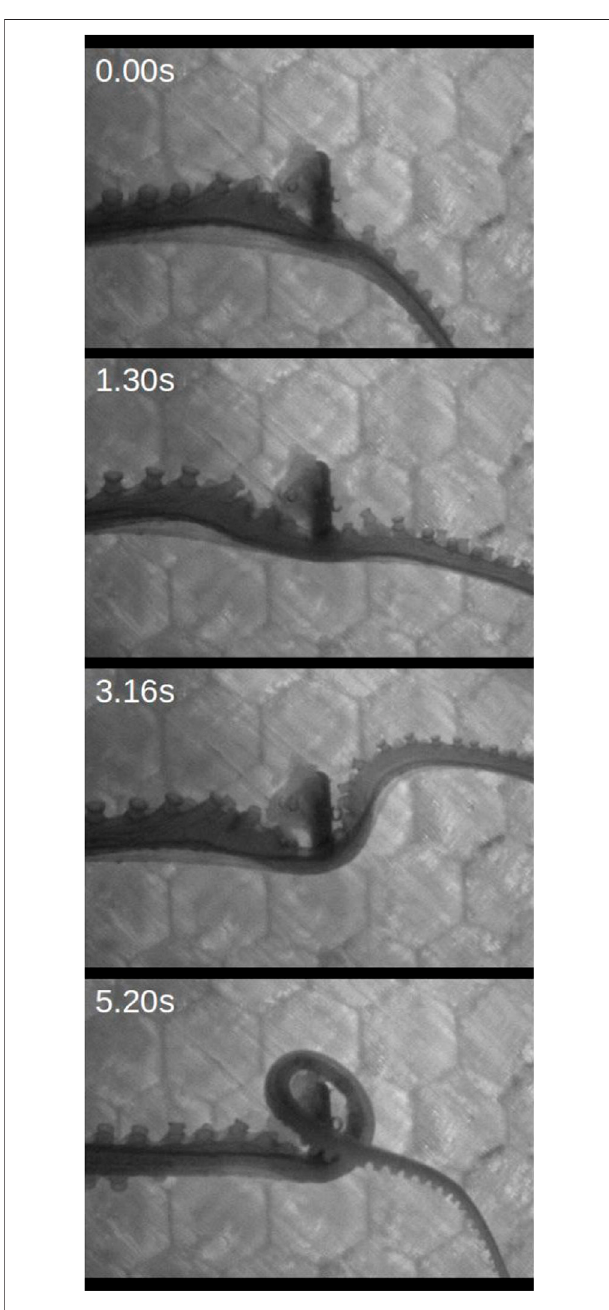
FIGURE 4 | Sucker recruitment used to grasp shrimp meat during foraging. Consistent with localized spread of sucker recruitment, orientation and movement of suckers towards the food occurs in waves propagating from the point of food contact. See also Supplementary Video S1 .